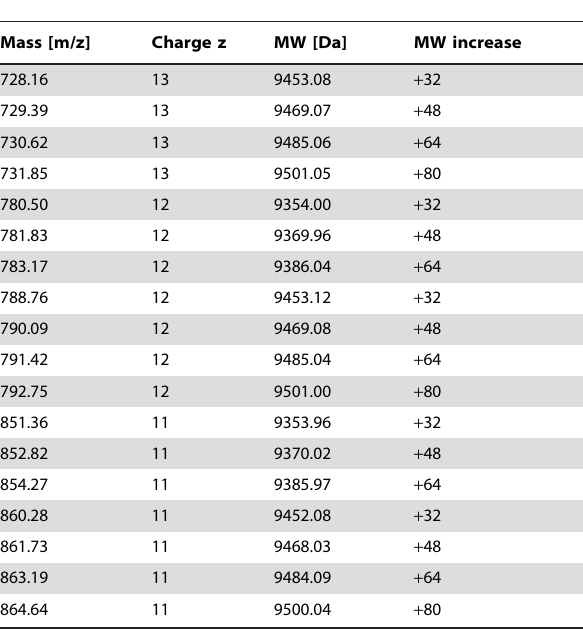
The molecular masses correspond to values shifted by + 16, + 32, + 48, + 64 Da caused by methionine oxidation (sulfoxide, + 16 Da and sulfone, + 32 Da for each residue, and combinations thereof, maximal + 64 Da) and by + 80 Da for the additional oxidation of tryptophan 23.